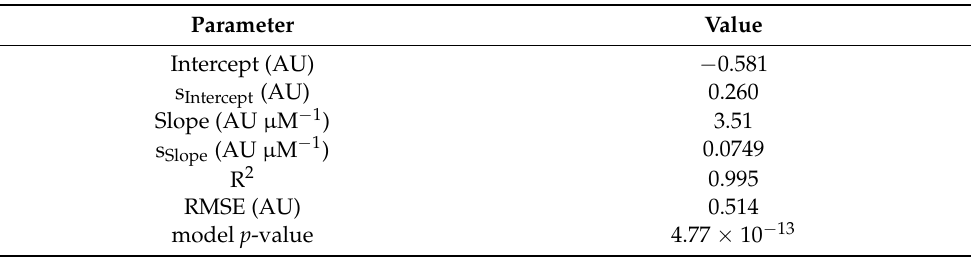
Table 5. Linear regression parameters. All values are reported with the corresponding measure unit, AU stands for (FLD) area unit.